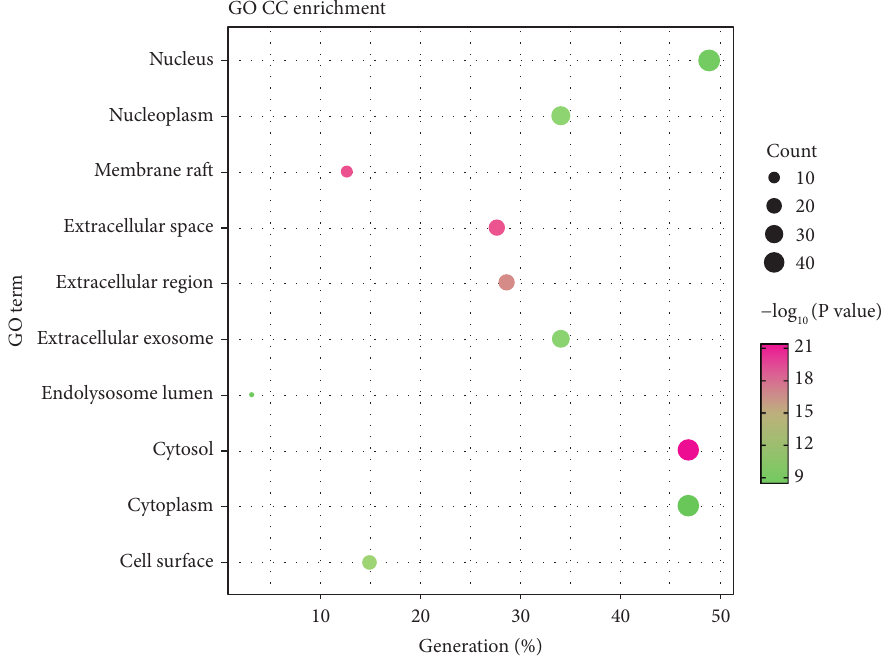
Figure 6: CC in GO enrichment